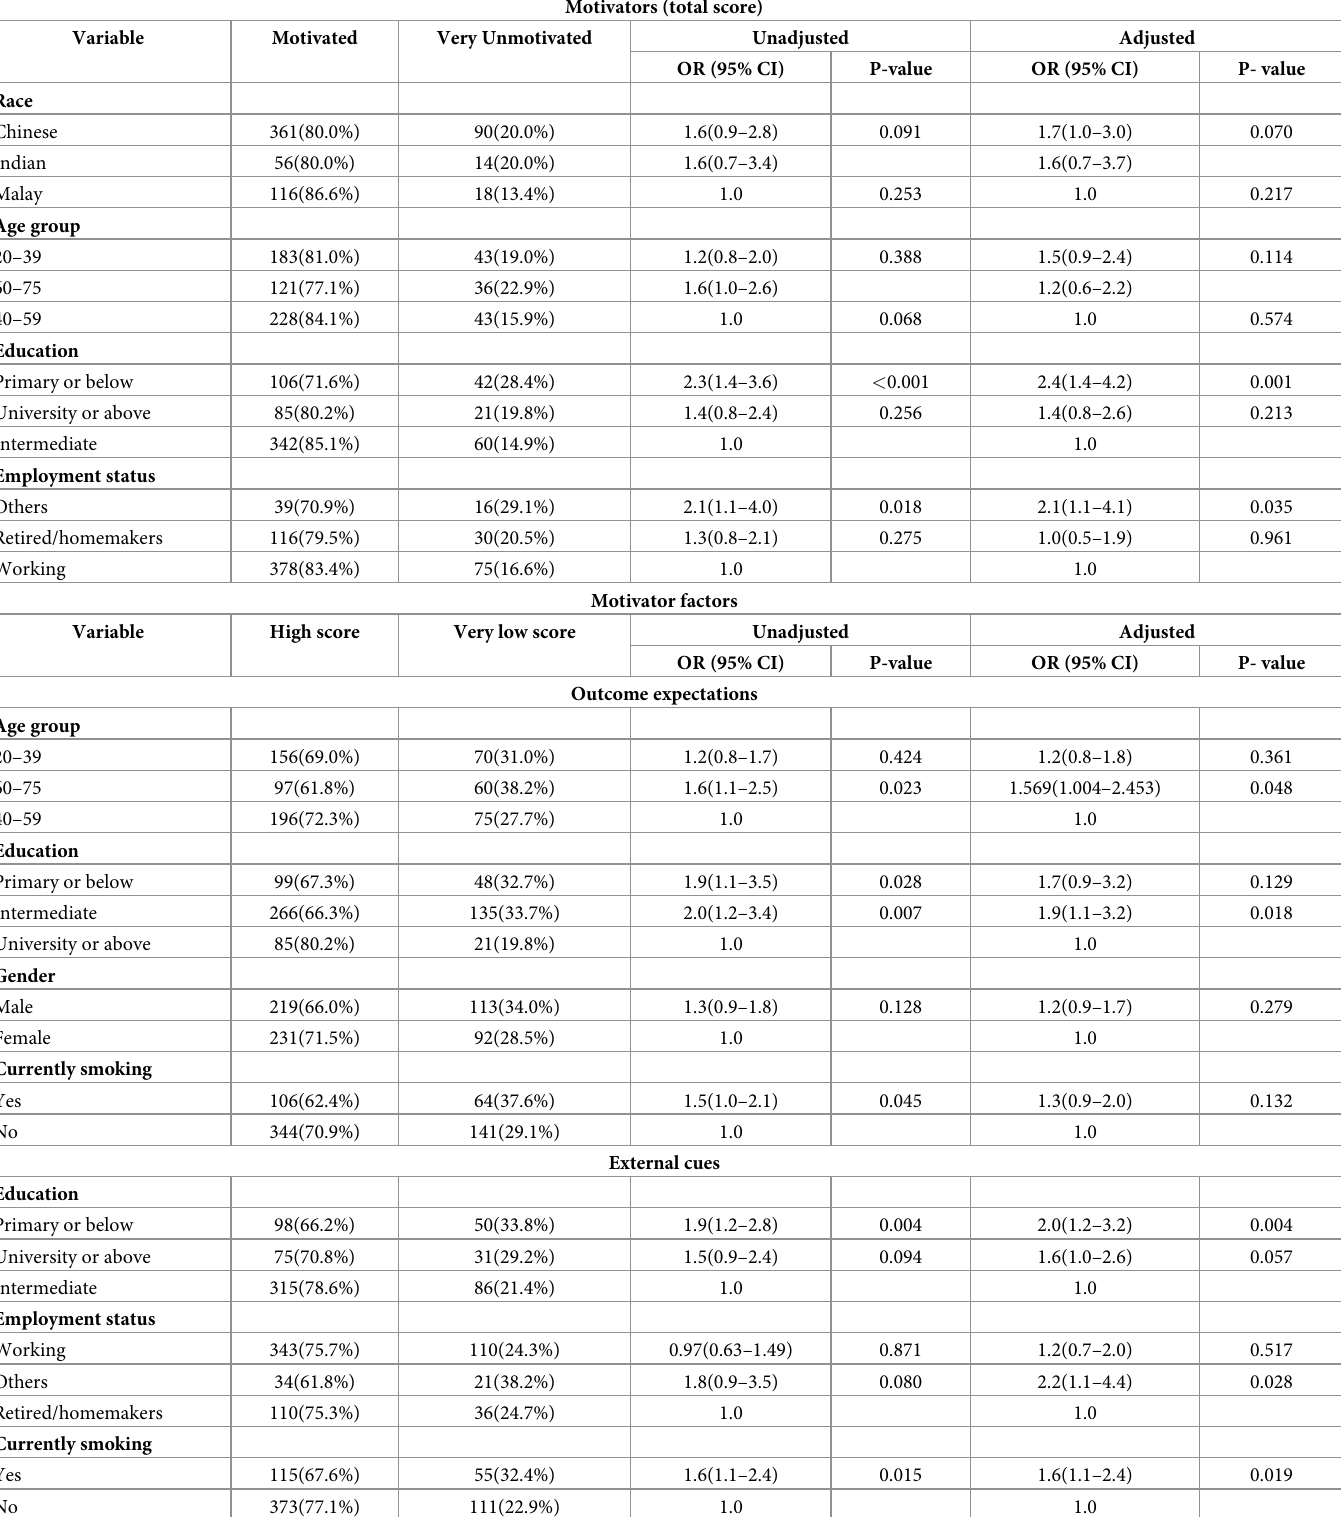
Table 3. Motivators and barriers among the physically inactive: Overall score and